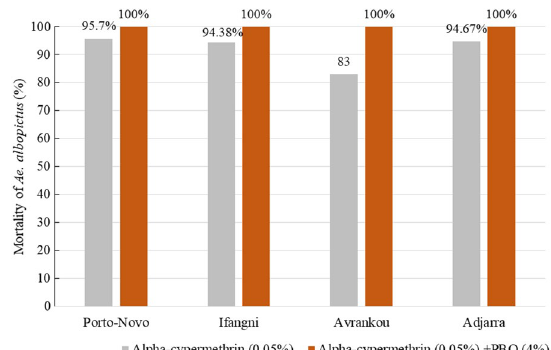
Fig. 3 Mortality rates of Aedes albopictus with alpha‑cypermethrin alone and alpha‑cypermethrin +